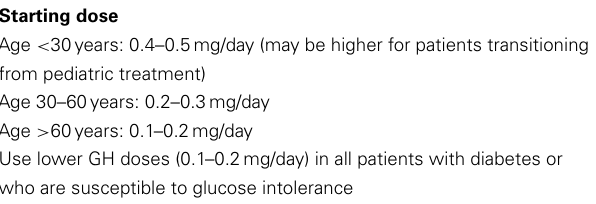
Table 5 | Recommendations for GH replacement therapy inAGHD (adapted from Cook et al.,